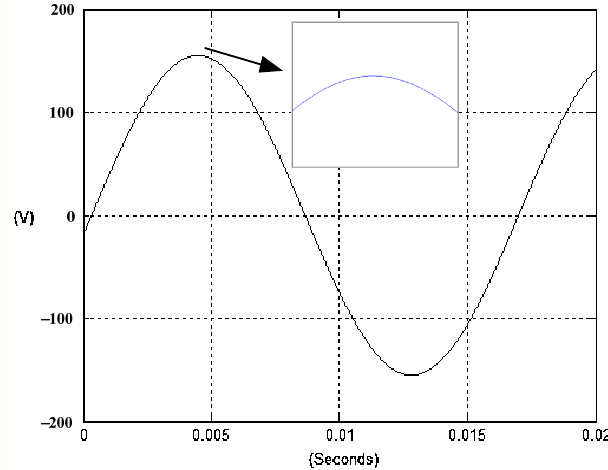
Figure 12. Simulated AC output voltage for the proposed closed-loop method at full load.